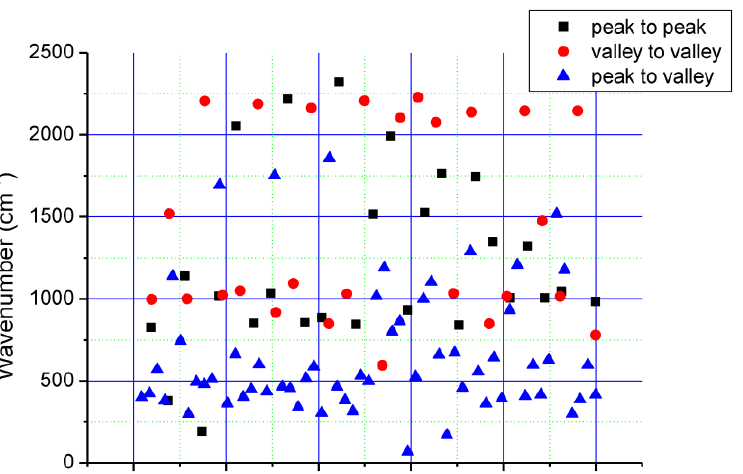
Table 1. Raman frequency shift (RS) in BBO crystal from Ref. (Chin. Phys. Lett. 19 (2002) 205).